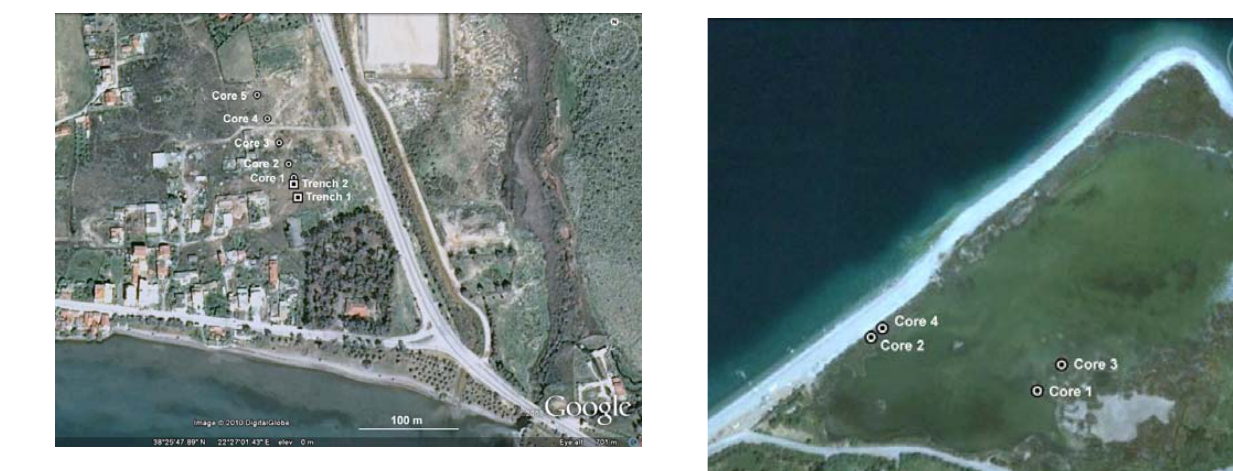
Fig. 2. Google image of the Kirra field site, left in the photo, situ- ated on the fluvial plain east of Itea. The local river is shown on the right in the photograph.